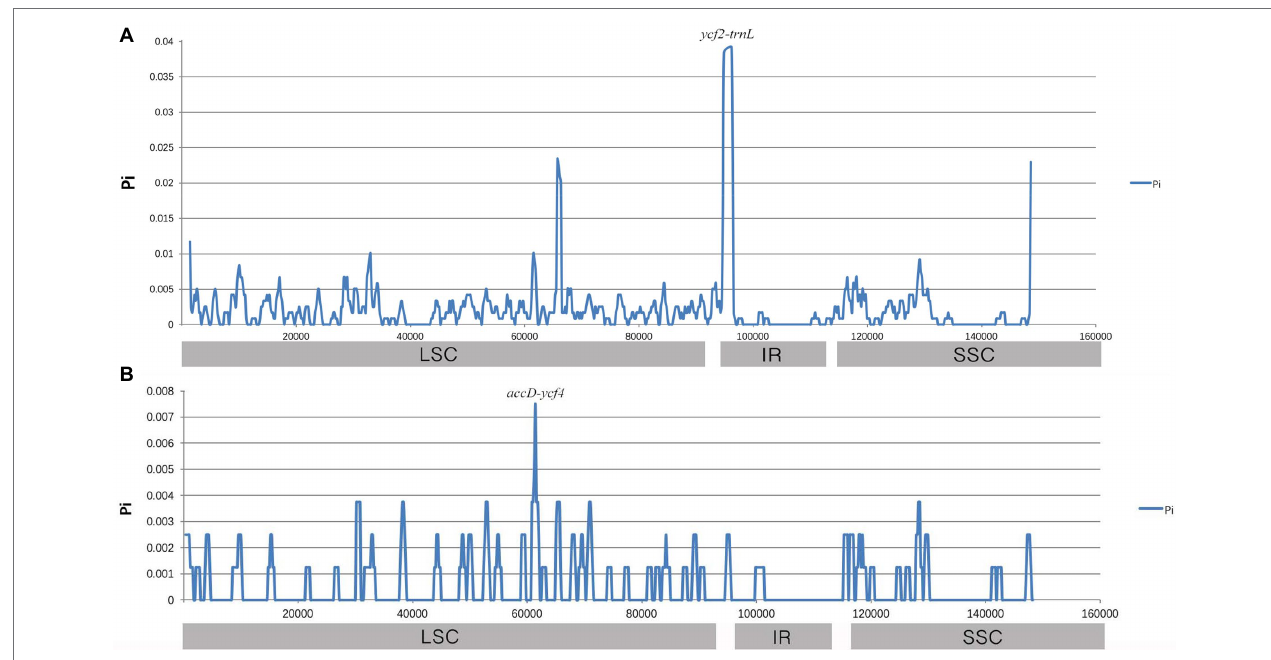
FIGURE 7 | Sliding window analysis of the whole chloroplast genomes. Window length: 800 bp; step size: 200 bp. X -axis: position of the midpoint of a window. Y -axis: nucleotide diversity of each window. (A) Pi among C. vaginatum , L. sinense , and L. jeholense . (B) Pi between L. sinense and L. jeholense .